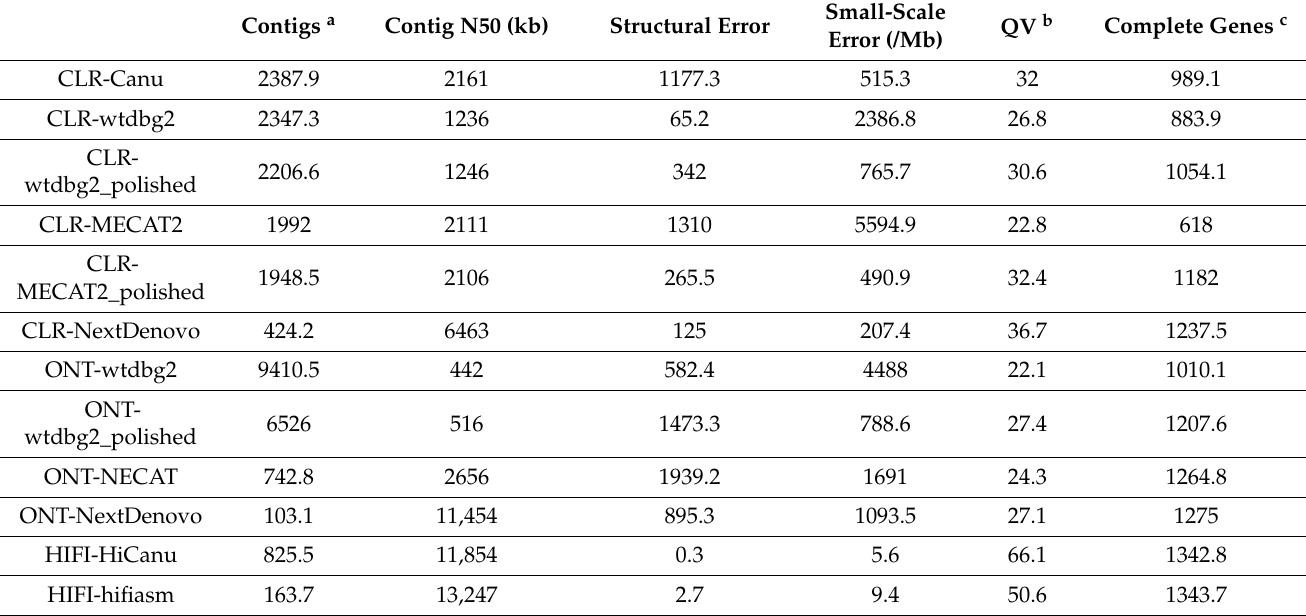
Table 2. The mean of metric values of different assemblers on CLR, ONT, and HIFI datasets. Contig N50 (kb) Structural